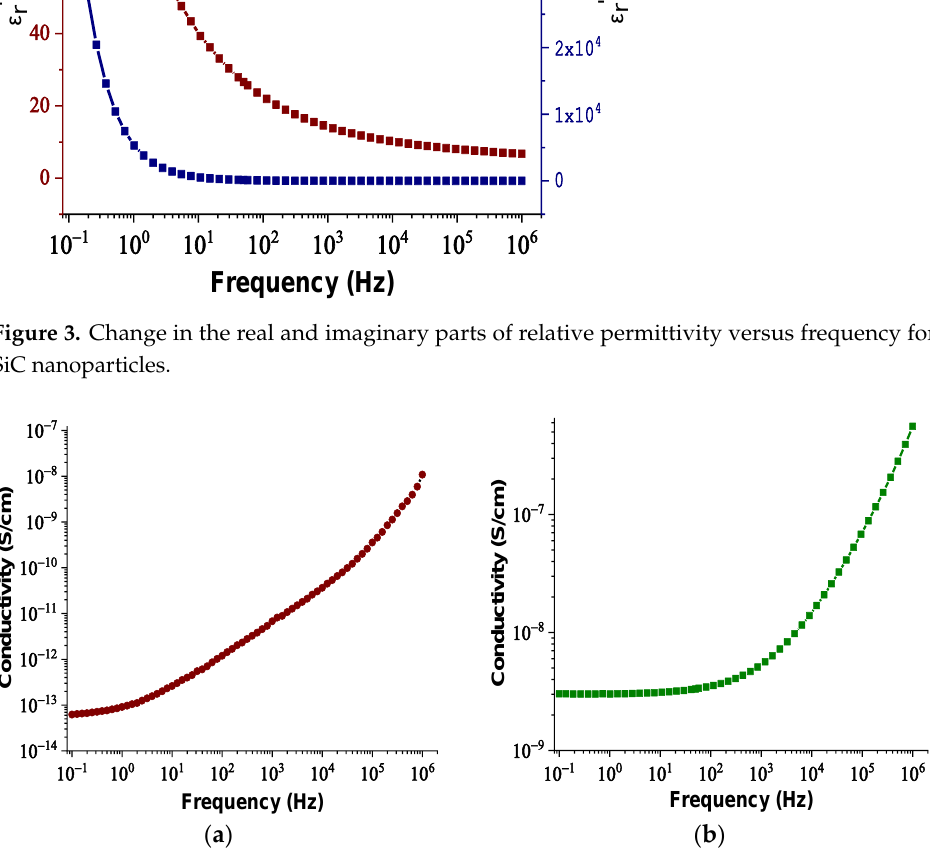
Figure 4. Change in electrical conductivity versus frequency: ( a ) for the matrix sample and ( b ) for the SiC nanoparticles. Table 1. Identification of the